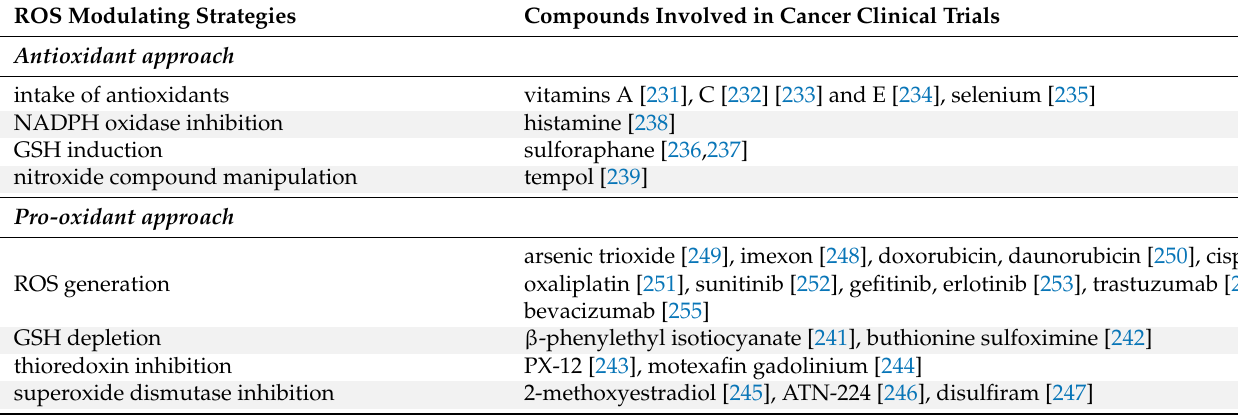
Table 1. ROS-modulating agents explored in cancer clinical trials.